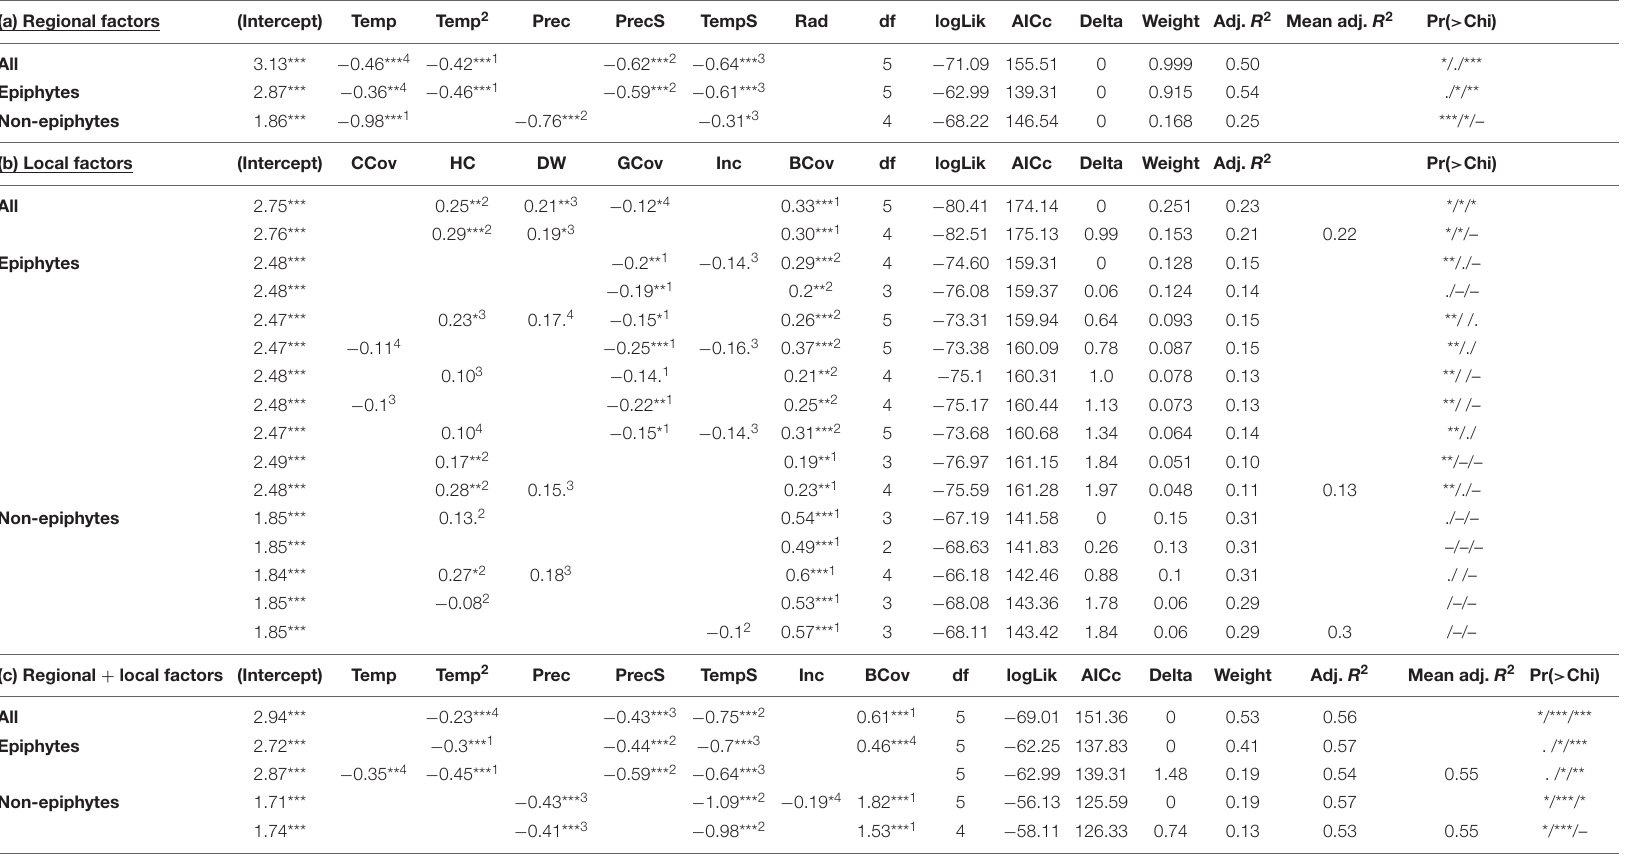
TABLE 1 | Summary of the best models resulting from the regional (a), local (b), and combined regional + local dataset (c) within (cid:49) AICc =